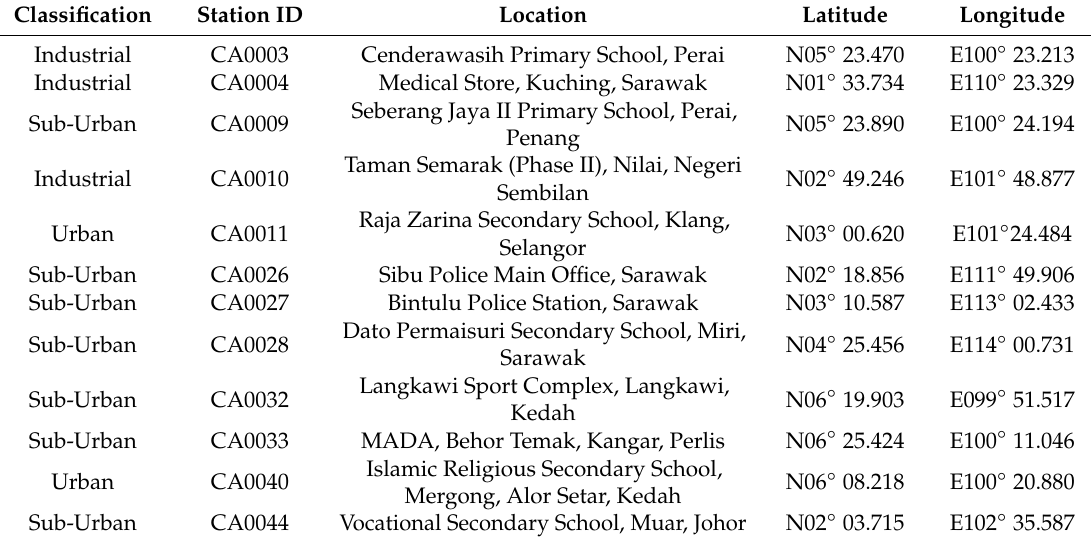
Figure 1. Study Areas. Table 1. Selected air monitoring stations in Malaysia affected during haze events.